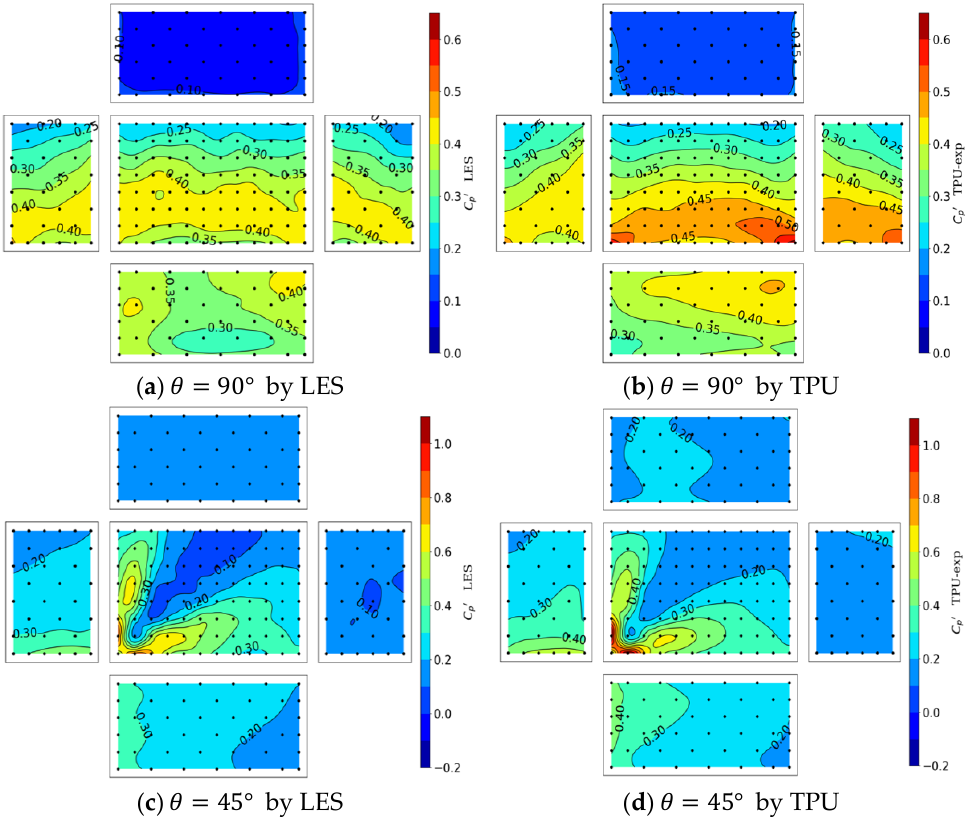
Figure 13. The fluctuation of surface pressure coefficient on an isolated low-rise building by LES (left side) and by TPU (right side).